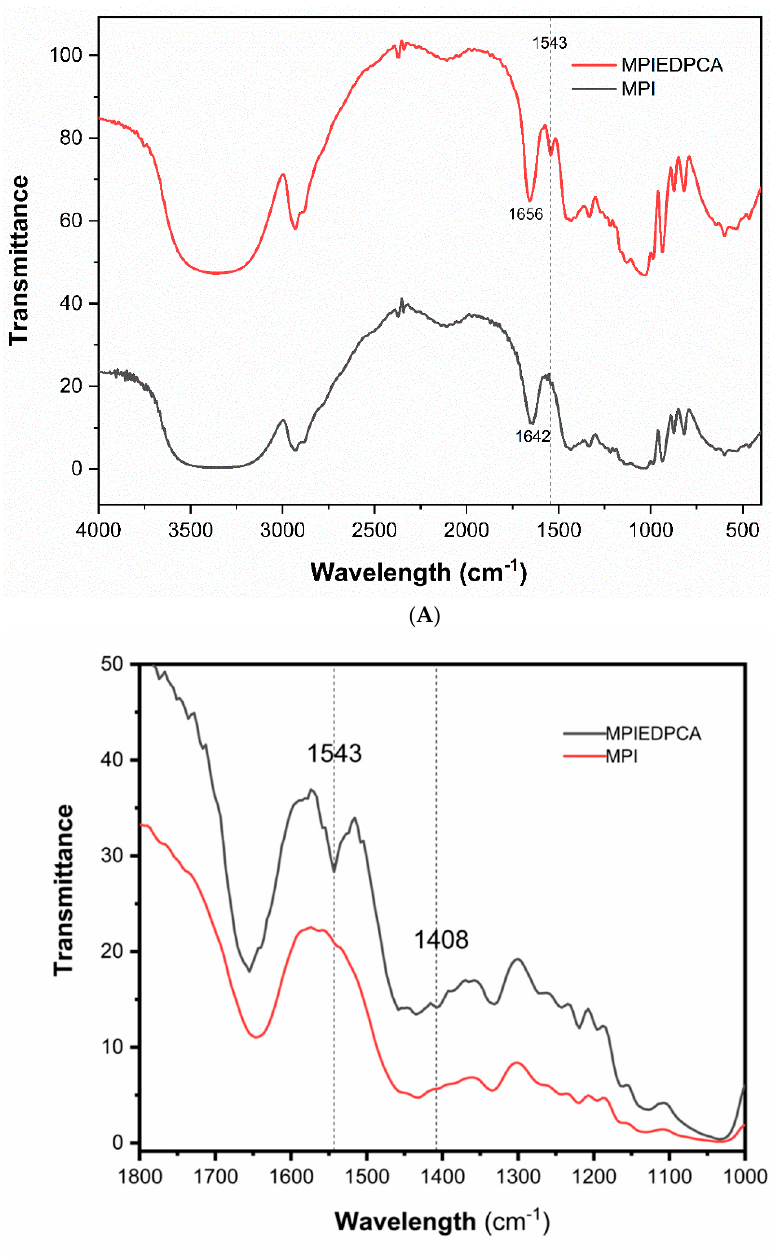
Figure 5. ( A ) The FTIR spectra of both MPIEDPCA and MPI. ( B ) The FTIR spectra of both MPIEDPCA and MPI between 1800 and 1000 cm − 1